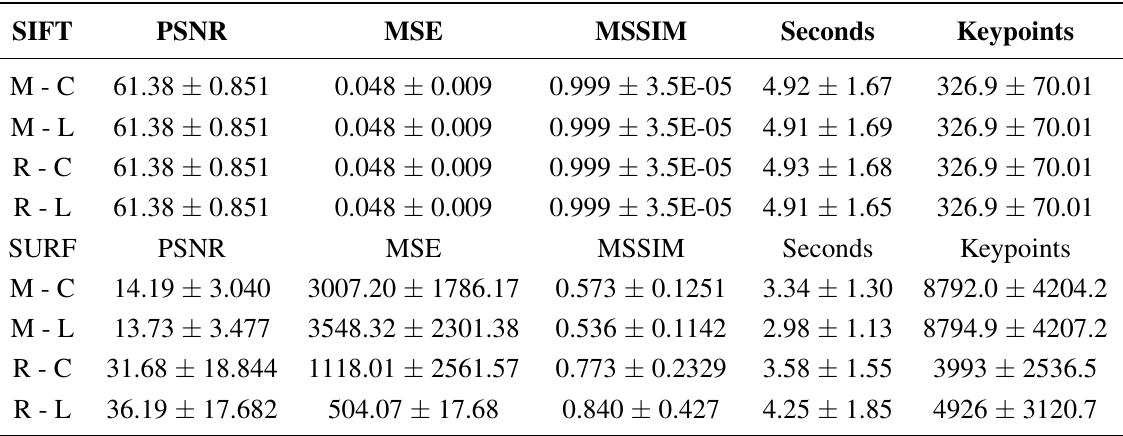
Table 2. Mean and standard deviation for variations of SIFT and SURF of PSNR measures, MSE and MMSIM, in wich R means RANSAC and M means LMED to find Homography Matrix, and C and L means Cubic and Linear